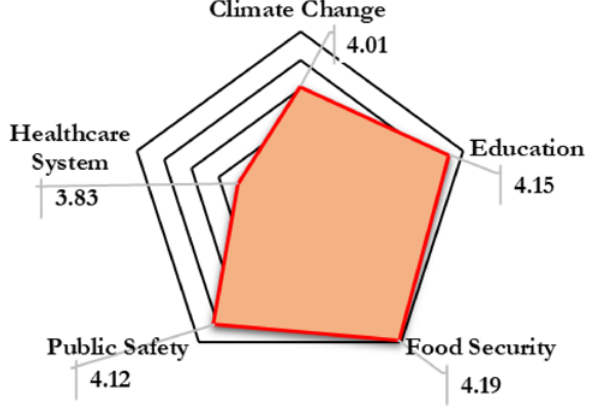
Figure 6 Group Mean Score for Factors influencing